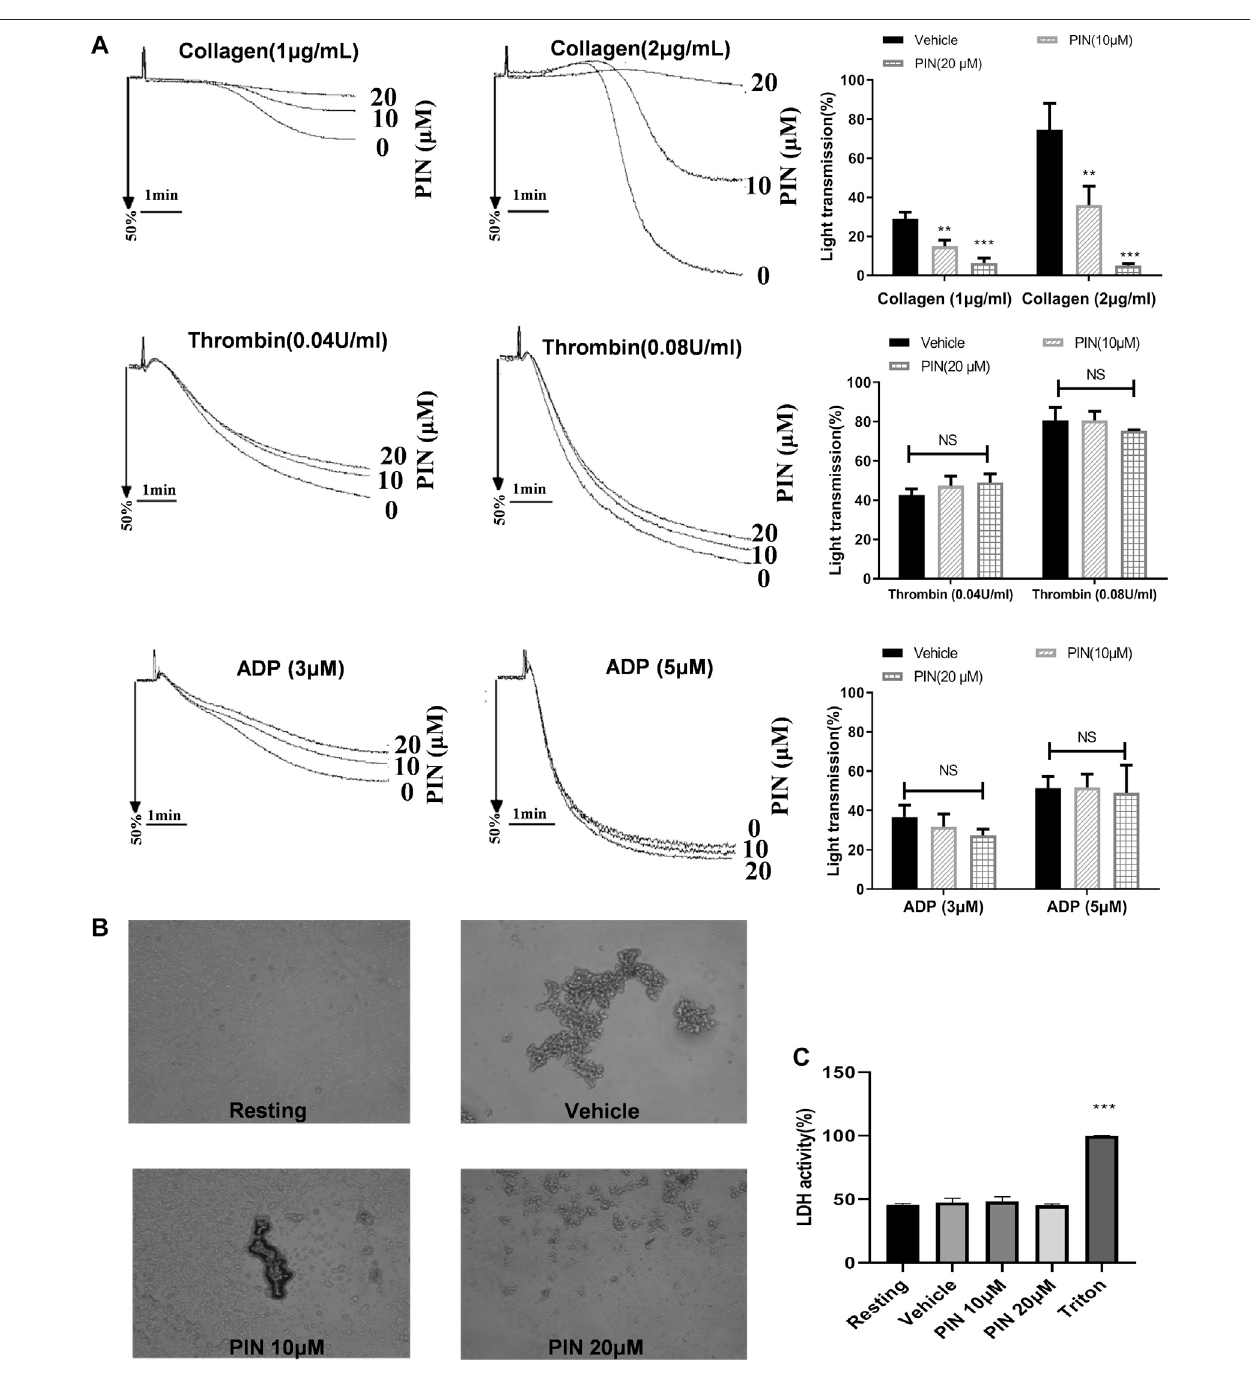
FIGURE1| EffectsofpimpinellinonplateletaggregationandLDHrelease. (A) Thewashedhumanplatelets(3 × 10 8 /ml)wereincubatedwithdifferentconcentrationsof pimpinellin(10and20 μ M)orthevehiclegroupfor5 min.Stimulatedplateletaggregationwithcollagen(1and2 μ g/ml),Thrombin(0.04and0.08U/ml),ADP(3and5 μ M). (B) Fixed and observed untreated platelets or platelets treated with vehicle or pimpinellin (10 and 20 μ M) and collagen 2 μ g/mL. Values are the average of three independent experiments ± S.E.M. (C) Toassessthecytotoxicity,plateletswerepre-incubated with0.1%DMSO(vehicle),orpimpinellin(10and20 μ M)for 10min,and 20 μ lofthe supernatant from the aliquots was precipitated on an LDH-assay kit. Data are presented as the mean ± SEM ( n (cid:2) 9). One-way ANOVA followed by Bonferroni post-hoc analysis of the data. (** p < 0.01, *** p < 0.001 compared with the vehicle group, # p < 0.05 compared with the PIN 10 μ M group, NS means no signi fi cance.).